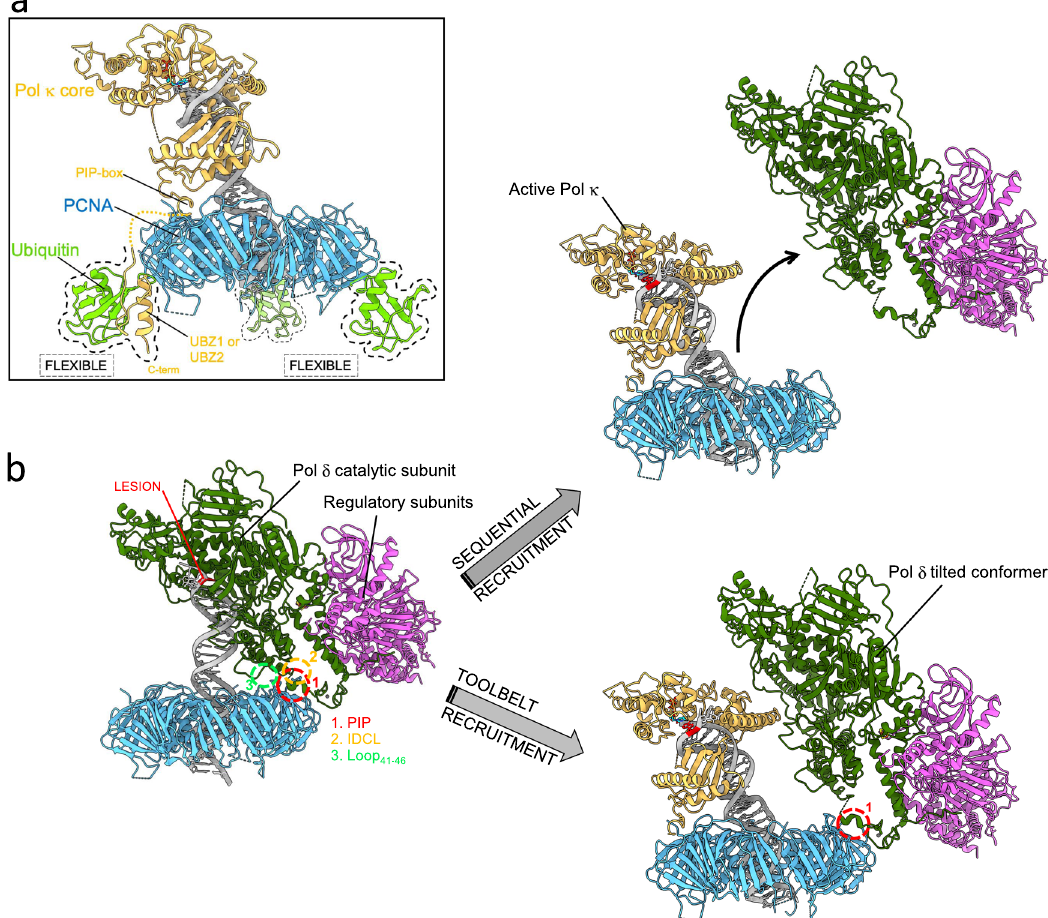
Fig. 6 Proposed models of function of Pol κ in TLS. a Pol κ interaction with mono-ubiquitylated PCNA. Pol κ binds PCNA encircling DNA through the internal PIP-box at the C-terminus of the PAD. If the PIP-box interaction is lost, Pol κ UBZ zinc fi ngers interact with the ubiquitin molecules fl exibly attached to the back face of Ub-PCNA, helping retain the polymerase to the DNA primer/template junction. Ubiquitins are modeled as in the cryo-EM structure of Pol κ − DNA − Ub-PCNA complex (Ub1 position), but may occupy alternate positions due to their intrinsic fl exibility. The orange dotted line represents the C-terminal disordered region connecting the Pol κ core to the UBZ domains. The homology model for Pol κ UBZ/Ubiquitin complex was built as shown in Fig. 5. b PCNA-directed polymerase swapping in TLS. At a lesion on the DNA template strand (highlighted in red), Pol δ holoenzyme stalls, and Pol κ is recruited to PCNA following two alternative paths. Either Pol δ dissociates into solution prior to or during Pol κ binding to PCNA and P/T DNA (sequential model), or Pol δ tilts remaining attached to the PIP-box site on PCNA and Pol κ is recruited to the exposed PIP-box site, capturing the P/T DNA released by Pol δ (toolbelt model). Tilting of Pol δ is achieved by disruption of two of the three indicated contact points with PCNA 36 , and allows to accommodate actively synthesizing Pol κ on PCNA in the “ active state ” without